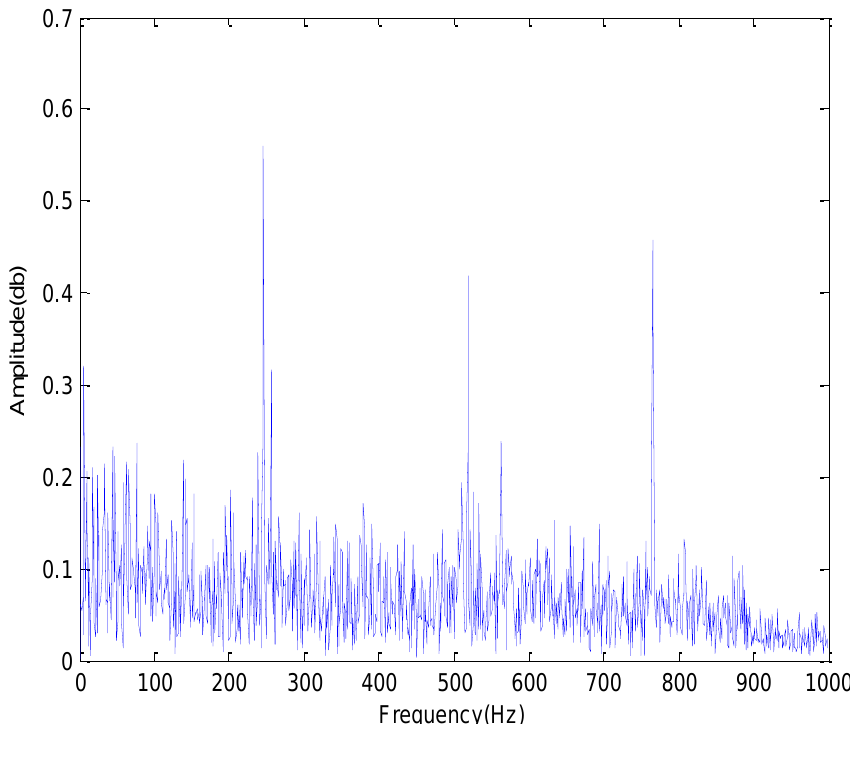
Figure 11. Spectrum of vibration signal after redundant second generation wavelet denoising and Hilbert